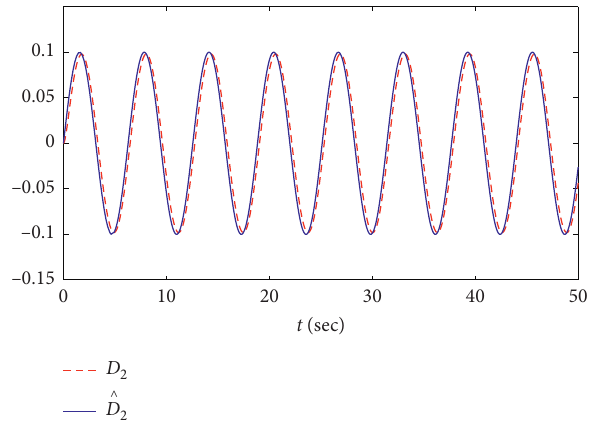
Figure 7: The estimation result of the sensor fault D